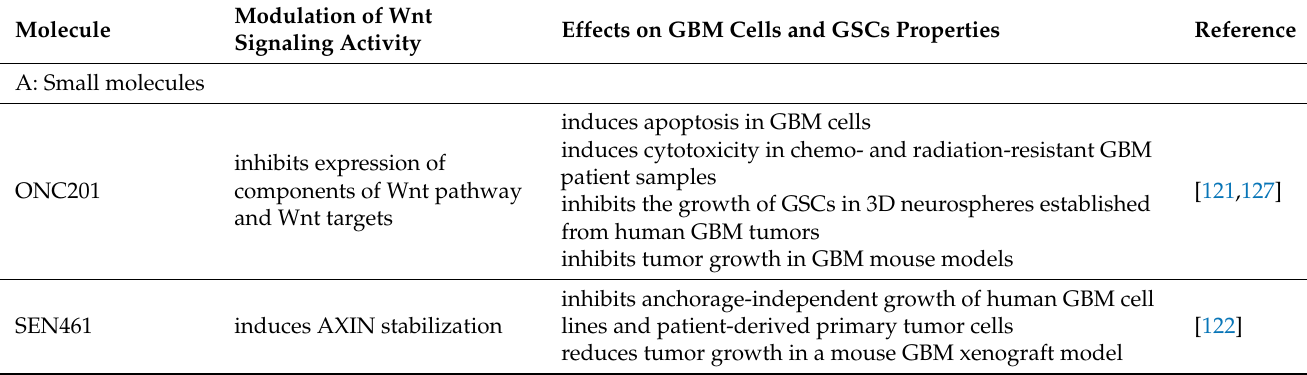
Figure 3. Overview of the Wnt/ β -catenin signaling cascade, targets for potential therapeutic inter- vention in GBM and molecules investigated in preclinical and clinical studies (based on the data listed in Table 1). Mechanisms of modulation of Wnt/ β -catenin activity in GBM (described in detail in Table 1) include (1) down-regulation of expression of Wnt components and Wnt targets, (2) promo- tion of β -catenin degradation, (3) increasing β -catenin stability, (4) inhibition of β -catenin nuclear translocation, (5) inhibition of β -catenin/CBP transcription complex, (6) down-regulation of WNT secretion and (7) inhibition of Wnt/ β -catenin-WISP1 signaling. Small molecules are presented in blue letters, natural agents in orange and repurposed drugs in purple. Molecules in red boxes inhibit expression and activity of denoted Wnt component or processes within the Wnt cascade. Molecules in green increase activity of denoted components. Red circle represents phosphate group; yellow circle represents palmitoyl groups. Based on [120,130] and references included in the main text and the Table 1. Table 1. Molecules targeting Wnt/ β -catenin cascade, mechanisms of action and effects on GBM cells and GSCs: A: Small molecules; B: Natural agents; and C: Repurposed